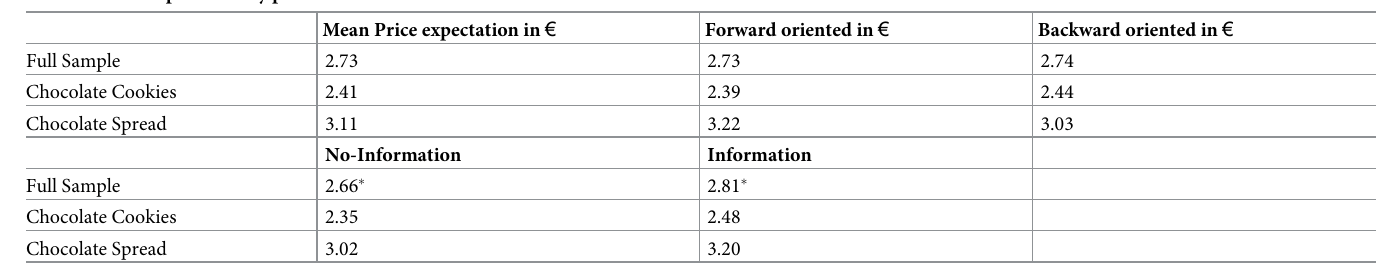
Table 3. Price expectation by product and information